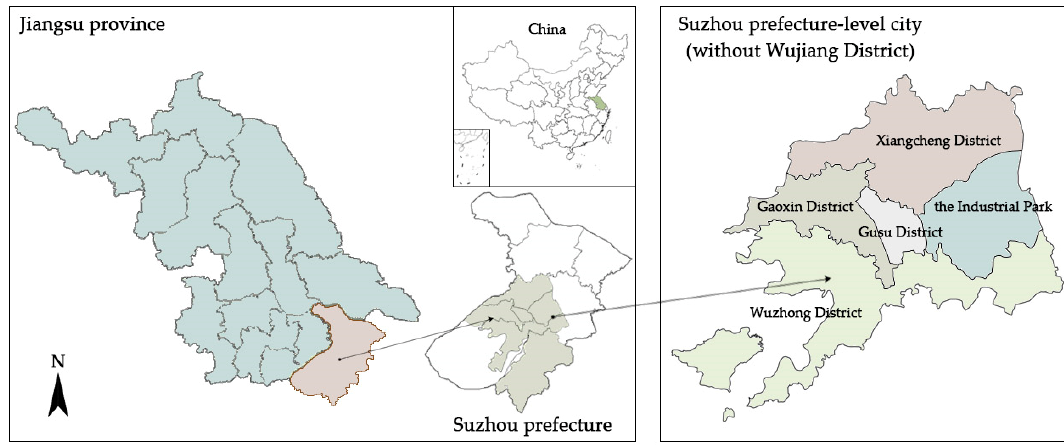
Figure 2. Location of the study